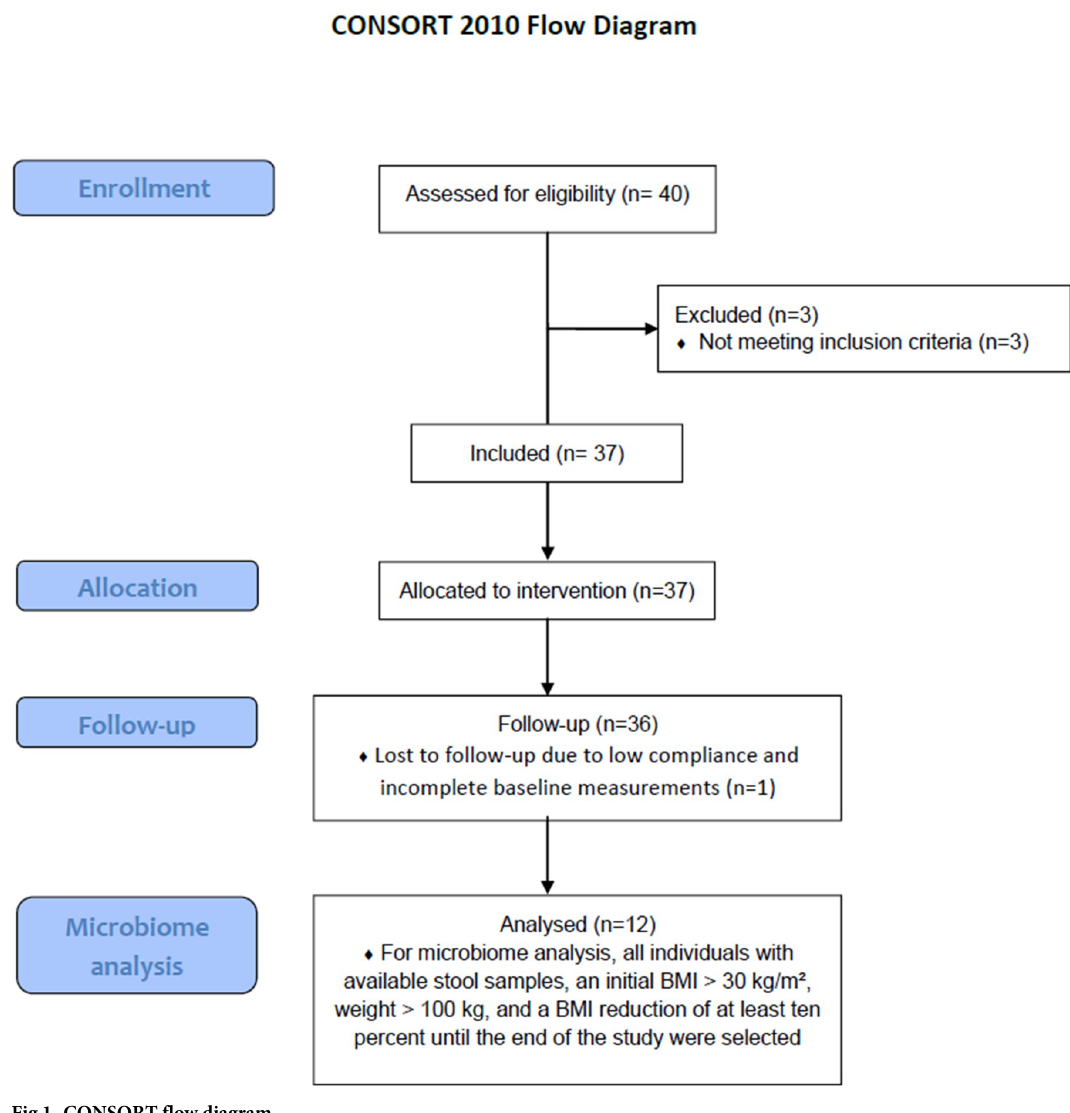
Fig 1. CONSORT flow